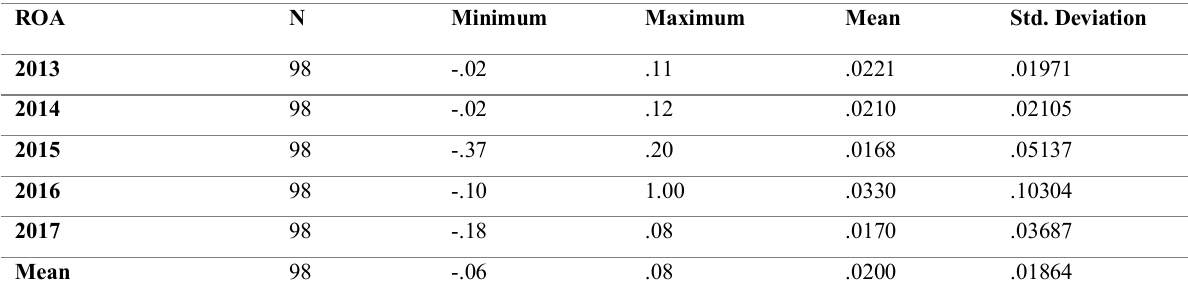
Table 3: Descriptive Statistics for return on